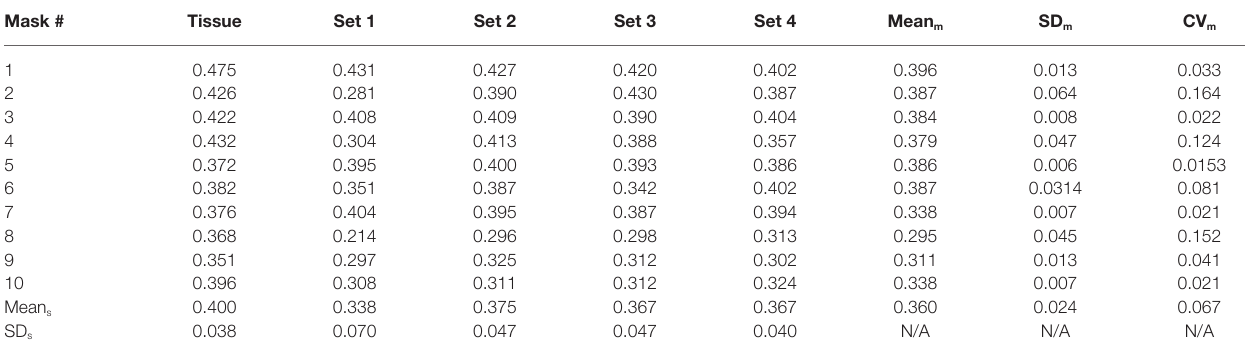
TABLE 1 | Repeated measurements of mean resistance (hPa.s.L − 1 ) for 10 masks (Set 1–4) and their tissue airflow resistance (Tissue). Mask # Tissue